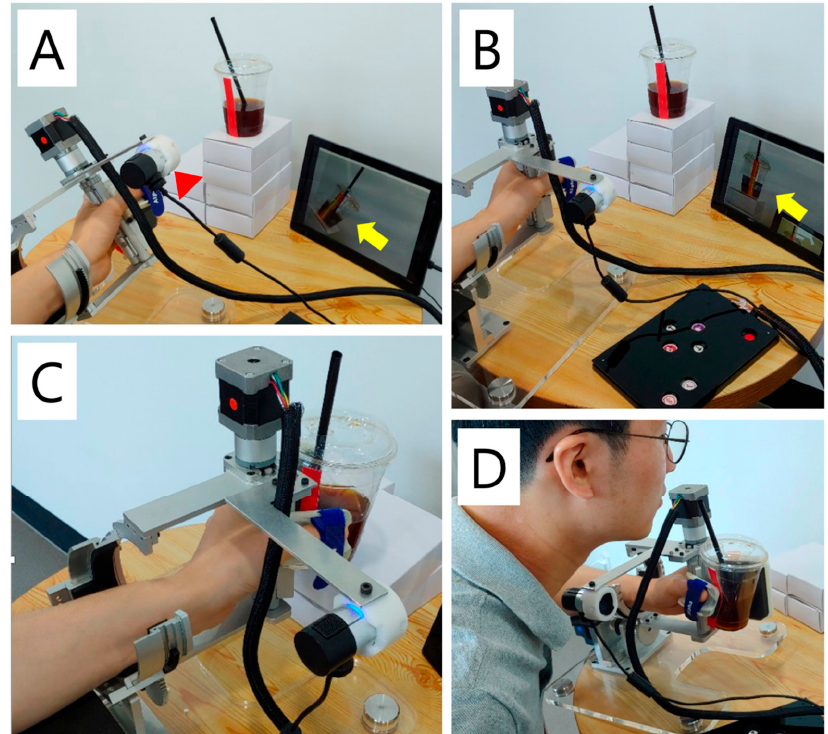
Figure 5. Main concept of the image processing-based user-intent driven distal upper limb rehabilitation robot is shown. ( A ) The user aims the robot hand at the target (coffee cup) and confirms the target object shown in the display using the control panel (shown on right lower hand of Figure B). A red arrowhead is the camera on the robot. The robot recognizes the target object and the long axis (yellow arrow); ( B ) when the user presses the execution button on the control panel to adjust the orientation, it automatically rotates the forearm supination / pronation axis to the appropriate orientation to grasp the object. Note the long axis rotated on the display screen (yellow arrow); ( C ) the user moves the robot to the object with the proximal muscle power (mainly shoulder), and press the grasp button on the control panel; ( D ) the user rotates the axis with the control panel so that he can drink